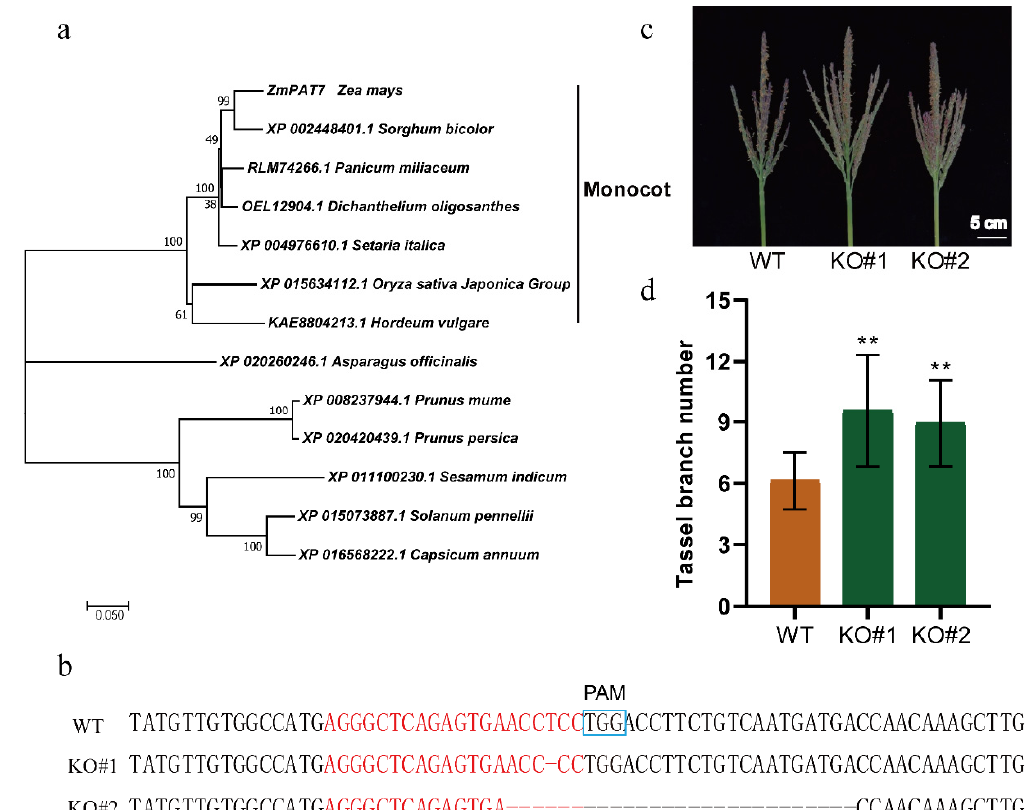
Figure 2. Phylogenetic tree of PAT proteins and the TBN performance in ZmPAT7 CRISPR/Cas9 mutants. ( a ) phylogenetic analysis of ZmPAT7 and 12 PAT proteins from other plants; ( b ) knockout of ZmPAT7 by CRISPR/Cas9 technology, the blue box is protospacer adjacent motif (PAM) sequence, the red font is single guide sequence (20 bp sequence adjacent to PAM) targeting ZmPAT7 in inbred line KN5585. Image ( c ) and statistics ( d ) show the TBN differences between wild-type (WT) and CRISPR-knockout (KO#1 and KO#2) plants. Data are represented as mean ± SD; ** indicates significant difference at 0.01 level by two-sided t -test.